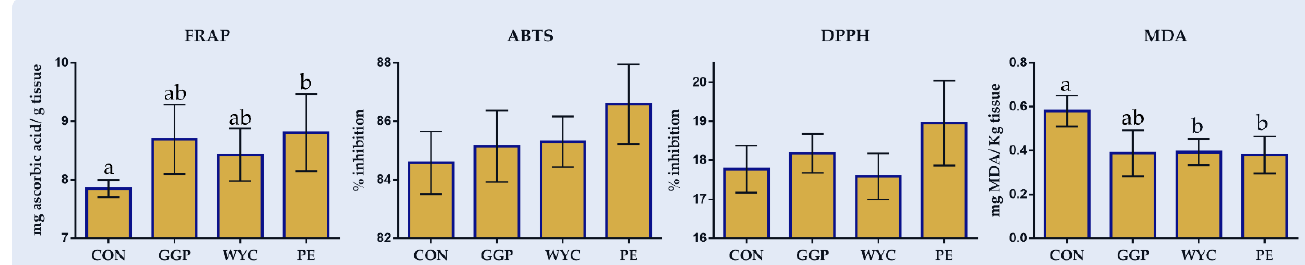
Figure 4. Total antioxidant capacity and lipid peroxidation index of breast muscle of broilers fed the four diets (Control; CON, ground grape pomace; GGP, dried wine lees extract; WYC, and grape stem extract included in soluble starch; PE) at 42 days.. Bars with different superscript (a, b) between dietary treatments differ significantly ( p ≤ 0.05) according to the analysis of variance (ANOVA) using post hoc multiple range test when appropriate.